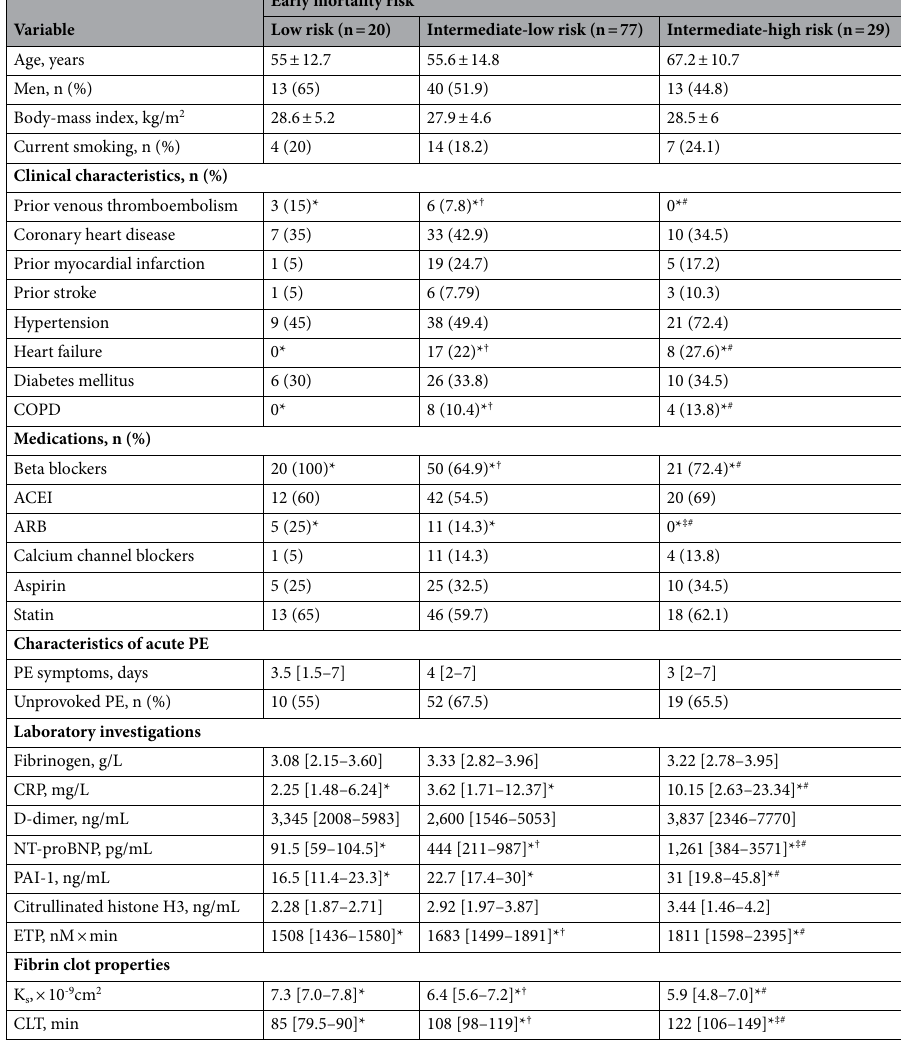
Table 1. Characteristics of patients with acute pulmonary embolism (PE) according to low, intermediate- low, and intermediate-high early mortality risk. ACEI angiotensin-converting enzyme inhibitors,